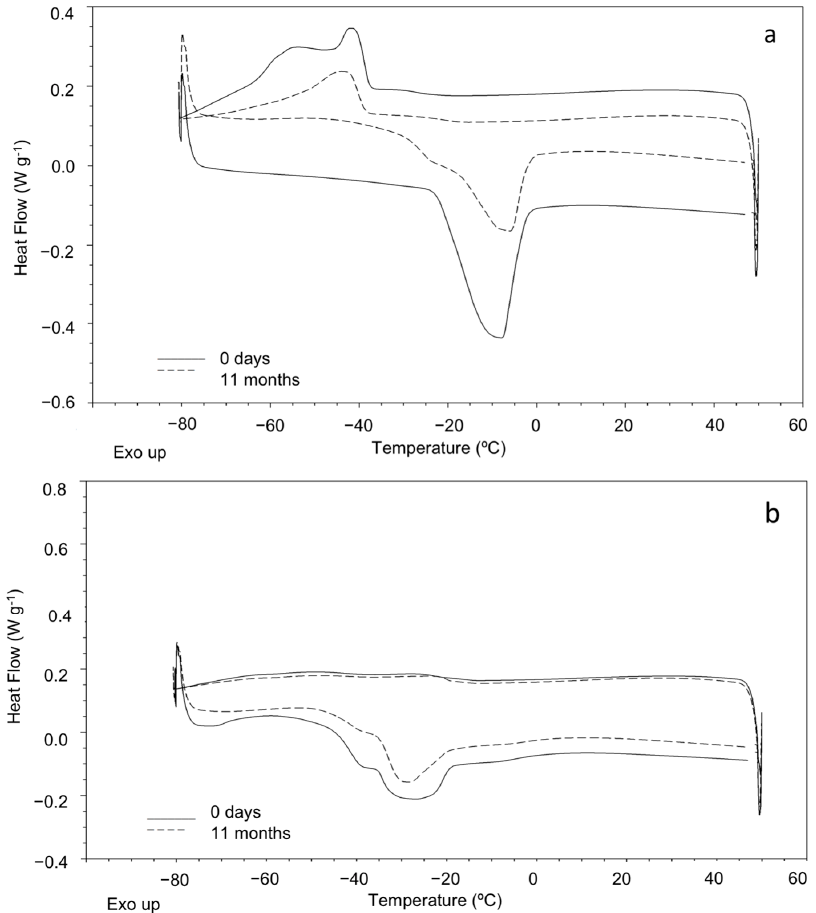
Figure 1. DSC curves obtained for roasted ( a ) and fried ( b ) sunflower seed samples at zero days and 11 months of storage at room temperature.